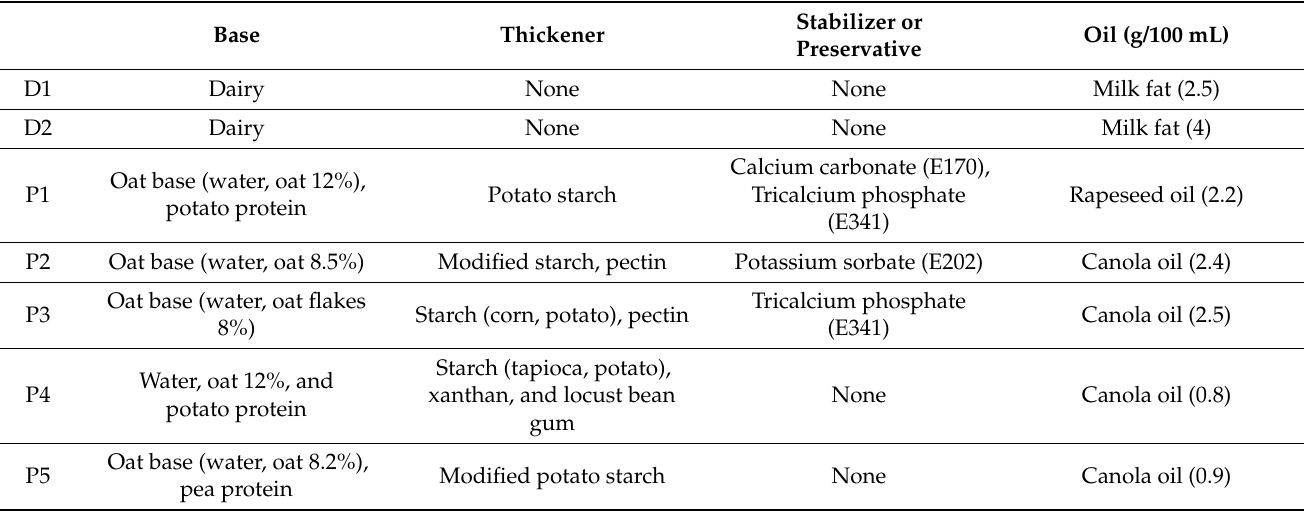
Table 1. The bases, thickeners, stabilizers, and oils as declared on the labels of all the samples.